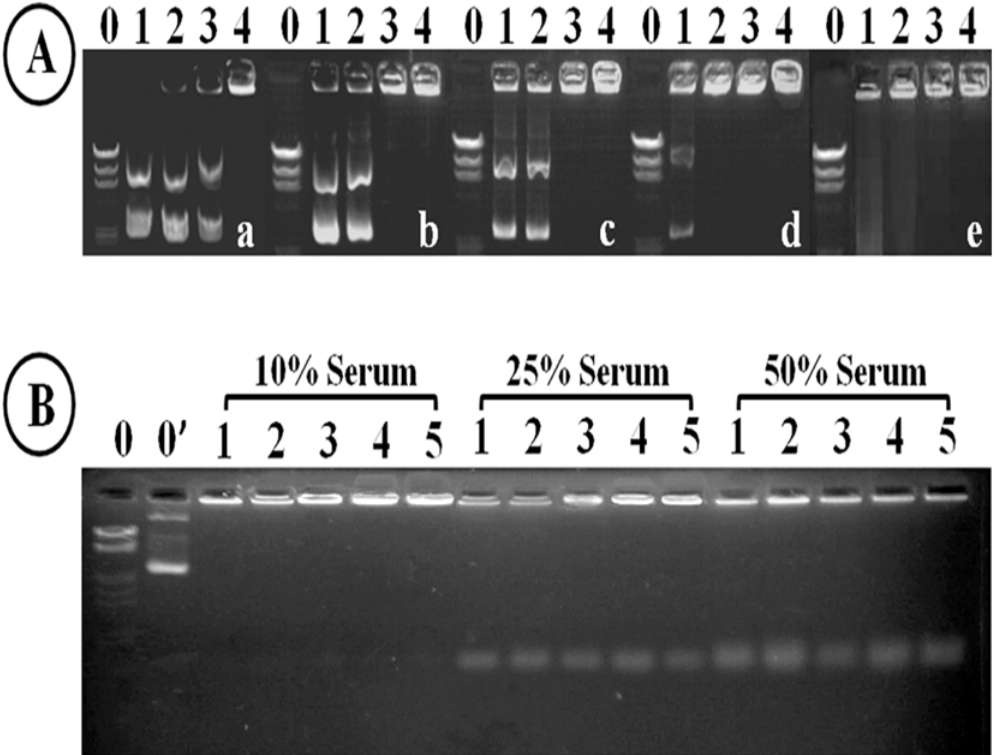
Fig 6. Agarose gel electropherogram. (A) Polyplexes at various N/P ratios without serum: (a) CS/pDNA, (b) CS- g -PEI-0.9/pDNA, (c) CS- g -PEI-1.8/pDNA, (d) CS- g -PEI-4.5/pDNA, and (e) CS- g -PEI-9.0/pDNA. Lane 0: DNA markers, lanes1-4: N/P ratios of 1, 2, 4 and 6, respectively. (B) Polyplexes at the N/P ratio of 6 in 10%, 25%, 50% serum, respectively. Lane 0: DNA markers, lane 0 ’ : pDNA, lane 1: CS/pDNA, lane 2: CS- g -PEI-0.9/pDNA, lane 3: CS- g -PEI-1.8/ pDNA, lane 4: CS- g -PEI-4.5/pDNA, lane 5: CS- g